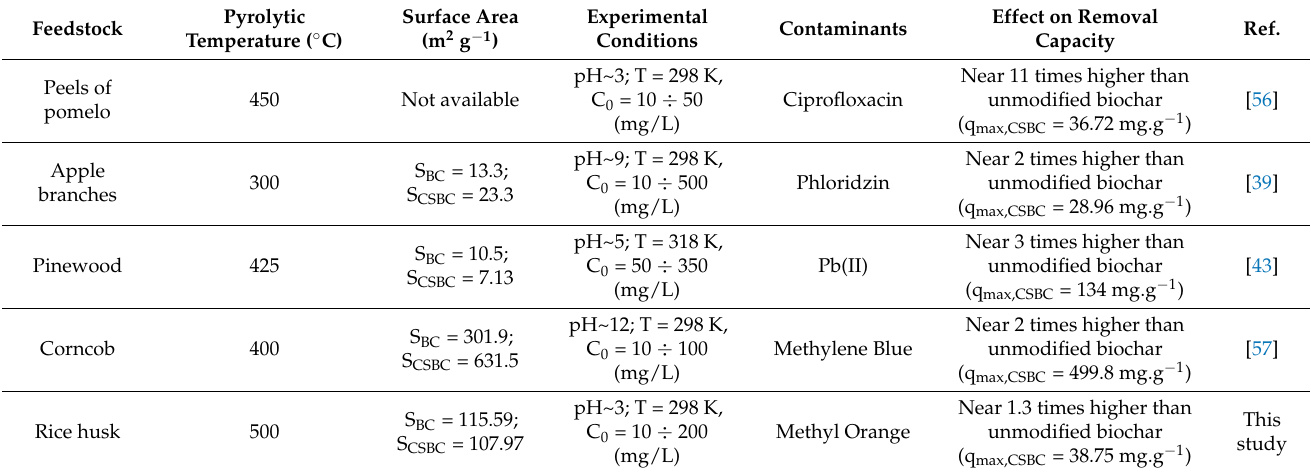
Table 3. Effect on removal capacity by chitosan coated on biochar